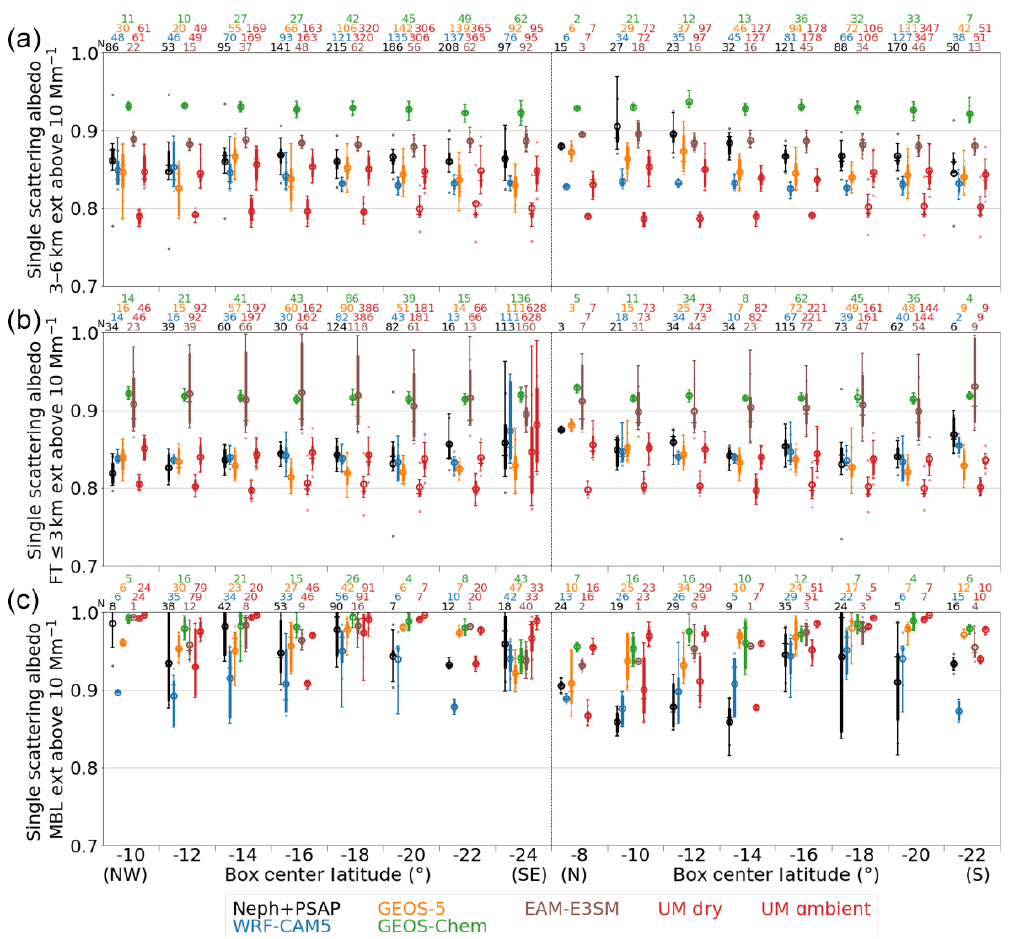
Figure 14. Same as Fig. 6 but for SSA. Note that the modeled SSA refers to the ambient humidity, whereas the observations are for dried